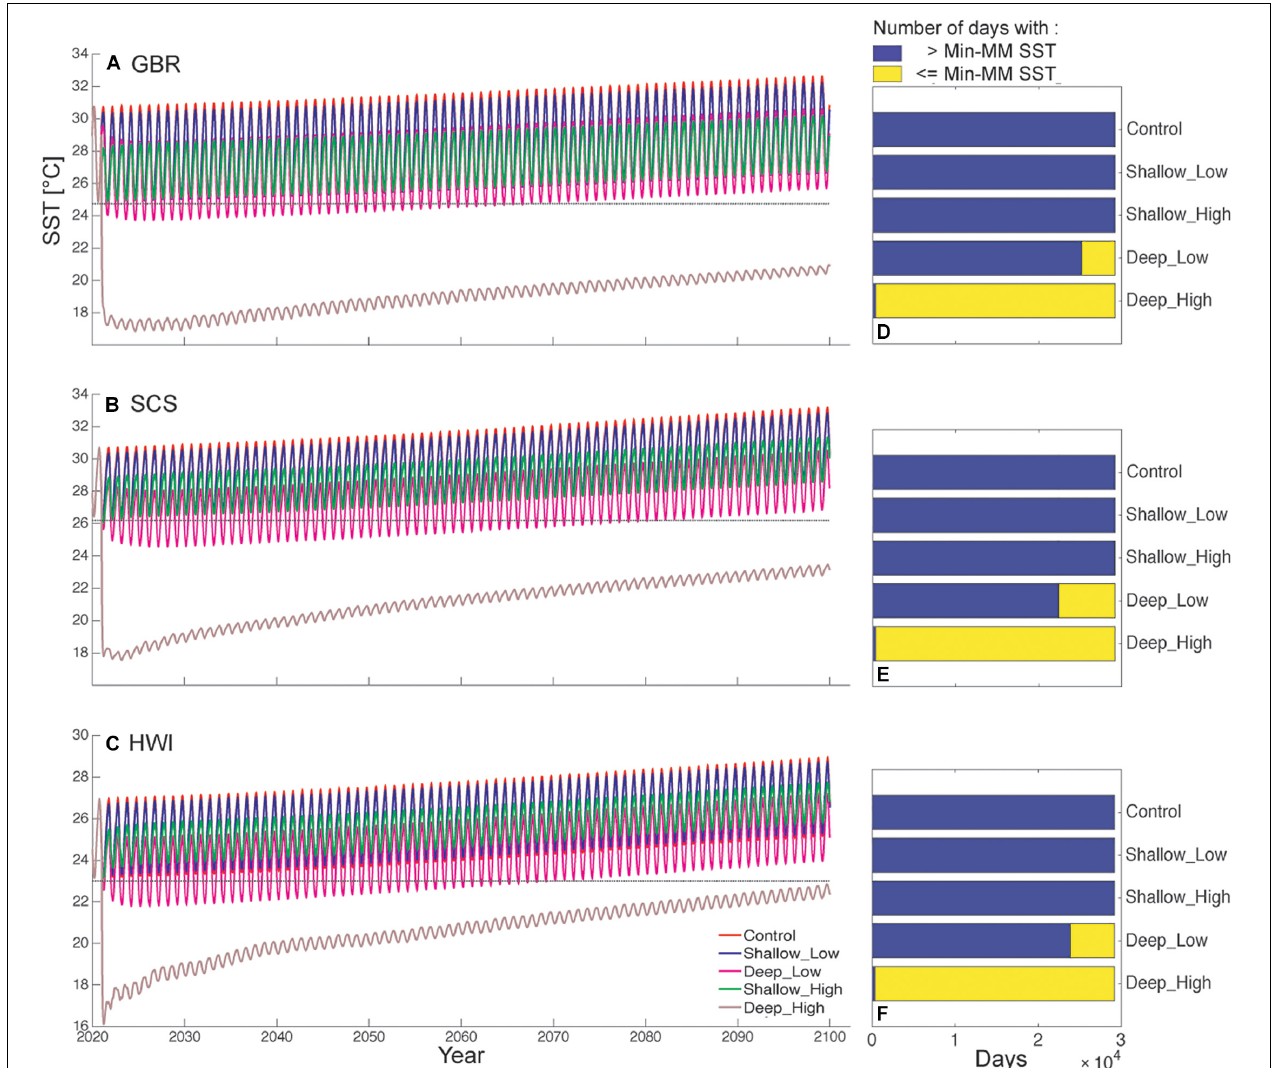
FIGURE 3 | Results of model runs for the Great Barrier Reef (GBR), South China Sea (SCS), and Hawaii (HWI) regions: The panels show area-averaged 5-day mean time series of sea surface temperature (SST) since 2020 (A–C) , and accumulated number of days with area-averaged SST below the coldest monthly mean climatology (Min-MM) by the end of 2099 (D–F) . Coldest monthly mean climatology SST was highlighted with black lines for each region in panel (A–C)